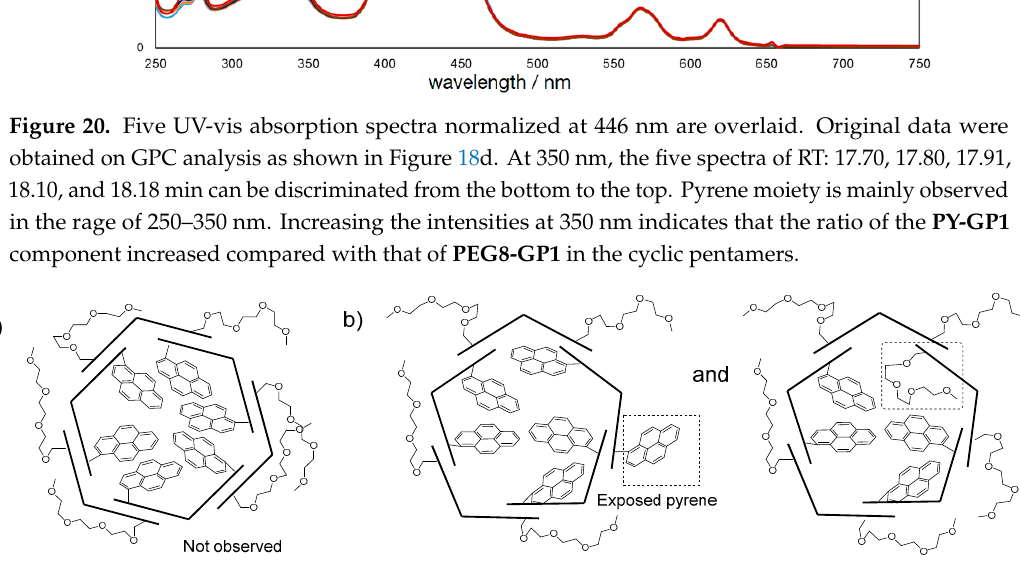
Figure 21. Possible heterogeneous cyclic structures composed of 1:1 ratio of PY-GP1 and PEG8-GP1 , ( a ) 3:3 micelle-like cyclic hexamer. All of the pyrene moieties are gathered inside, whereas PEG groups exist in the outside. Not observed. ( b ) A mixture of 3:2 and 2:3 of cyclic pentamer.